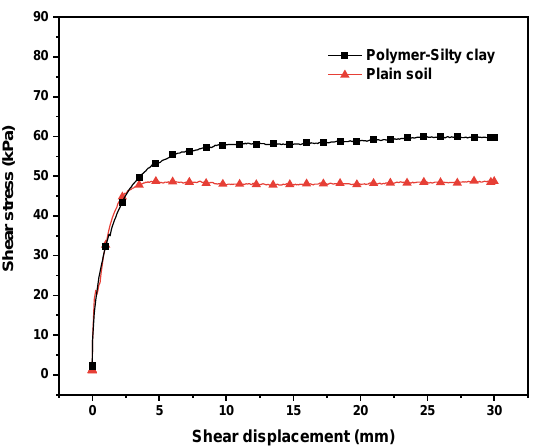
Figure 13. The relationships between shear stress and shear displacement of plain soil and polymer–silty clay.